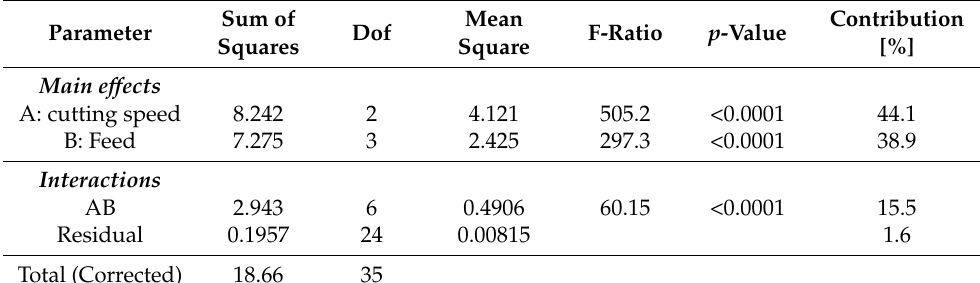
Table 5. ANOVA results for surface roughness. Dof: degree of freedom.